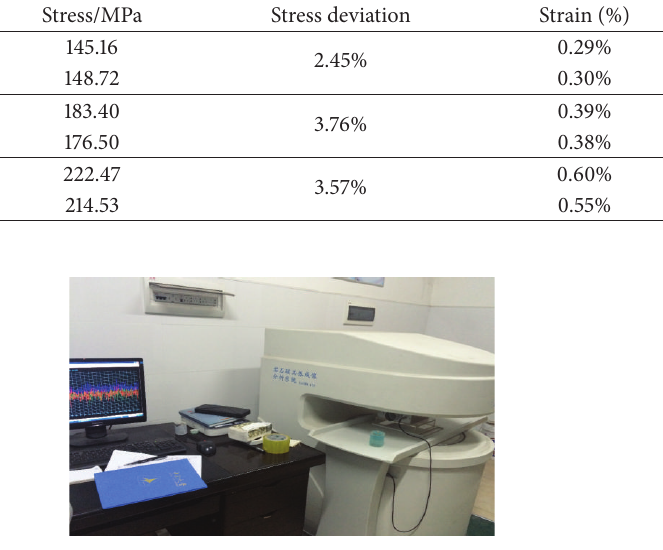
Figure 12: A MiniMR-60 nuclear magnetic resonance instrument (NMRI) for rocks.